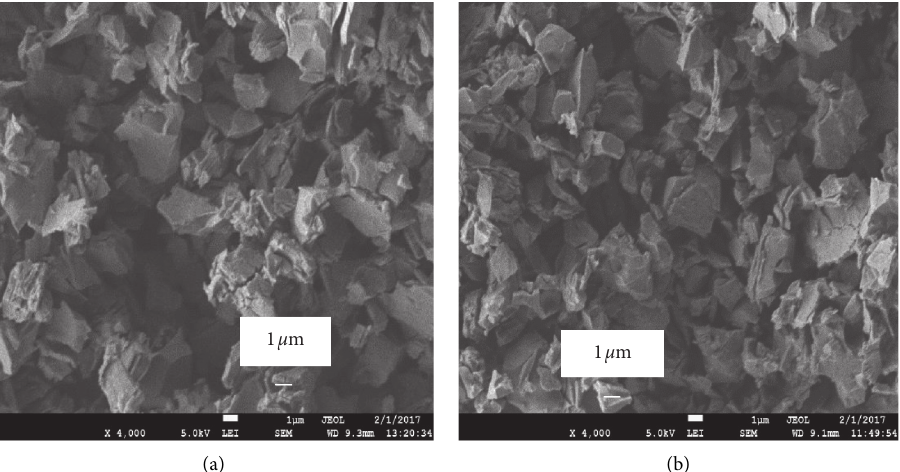
Figure 3: SEM images (cross-sectional) of La ° C for 8 10 Si 5.6 Al 0.2 Zn 0.2 O 26.7 (left) and La 10 Si 5.4 Al 0.4 Zn 0.2 O 26.6 (right) powders sintered at 1600 hours in La Si Al Zn O compound. The weight % of lantha- 10 5.4 0.4 0.2 26.6 num and zinc in La Si Al Zn O ( x � 0.2 and 0.4) are 10 6 − x − 0.2 x 0.2 27 − δ closely related values to each other as the theoretical compo- sitions of lanthanum and zinc in La Si Al Zn O 10 6 − x − 0.2 x 0.2 27 − δ ( x � 0.2 and 0.4) compounds are the same. The results show an approximate match between the weight % of elements in a compound and the theoretical composition of the elements in the compound [63]. Figure 5 compares the EIS plots of corresponding equivalent circuit used for fitting the Nyquist plots. The two semicircles of the Nyquist plots represent the grain conductivity and the grain boundary conductivity. The high frequency regime belongs to the grain contribution to the 1. Greater weight % of aluminium in conductivity and the medium range frequency belongs to the La Si Al Zn O is when the theoretical aluminium 10 5.4 0.4 0.2 26.6 grain boundary contribution to the conductivity of content of the La Si Al Zn O compound is greater 10 5.4 0.4 0.2 26.6 than La Si Al Zn O , whereas the weight % of silicon 10 5.6 0.2 0.2 26.7 and oxygen are greater in La Si Al Zn O when the 10 5.6 0.2 0.2 26.7 theoretical silicon and oxygen of the and 0.4) at a certain operating temperature was calculated using La equation (2) where the total resistance was obtained by fitting Si Al Zn O compound are greater than the 10 5.6 0.2 0.2 26.7